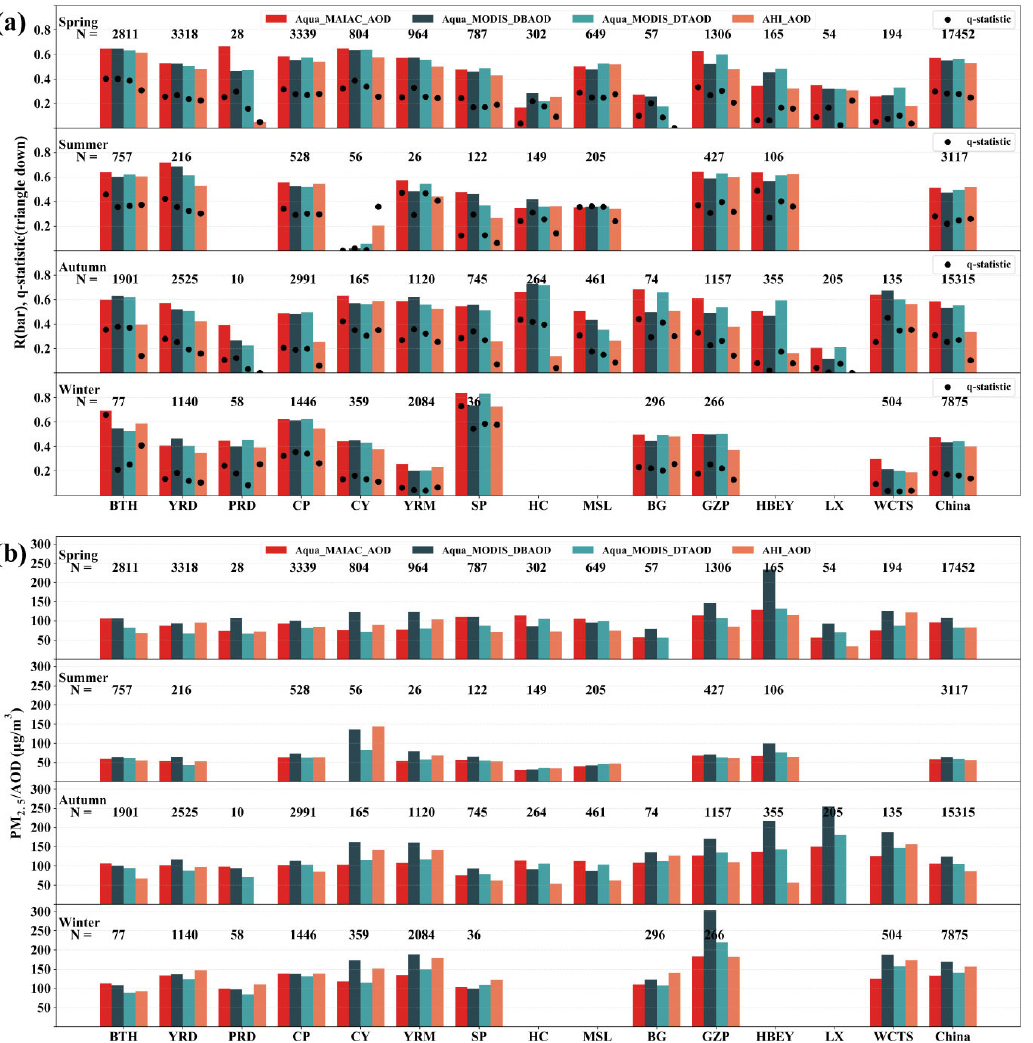
Figure 7. The relationships between Aqua MAIAC AOD, Aqua DT AOD, Aqua DB AOD, AHI AOD, and the ground-level PM 2.5 concentration over China and its typical regions during different seasons. ( a ) The correlation coefficient (bar) and the q statistic (black dots); ( b ) the ratio ( η ). Note that when calculating the η , the PM 2.5 is the same for all AODs.